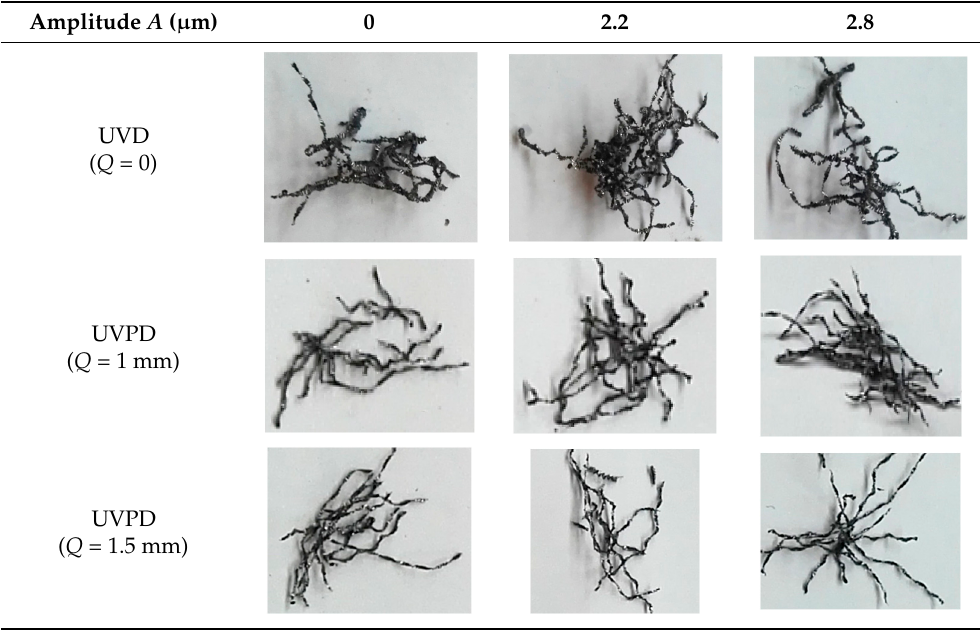
Table 3. Chip morphology comparison of UVD and UVPD. ( n = 1200 r/min, v f = 36 mm/min, f = 20